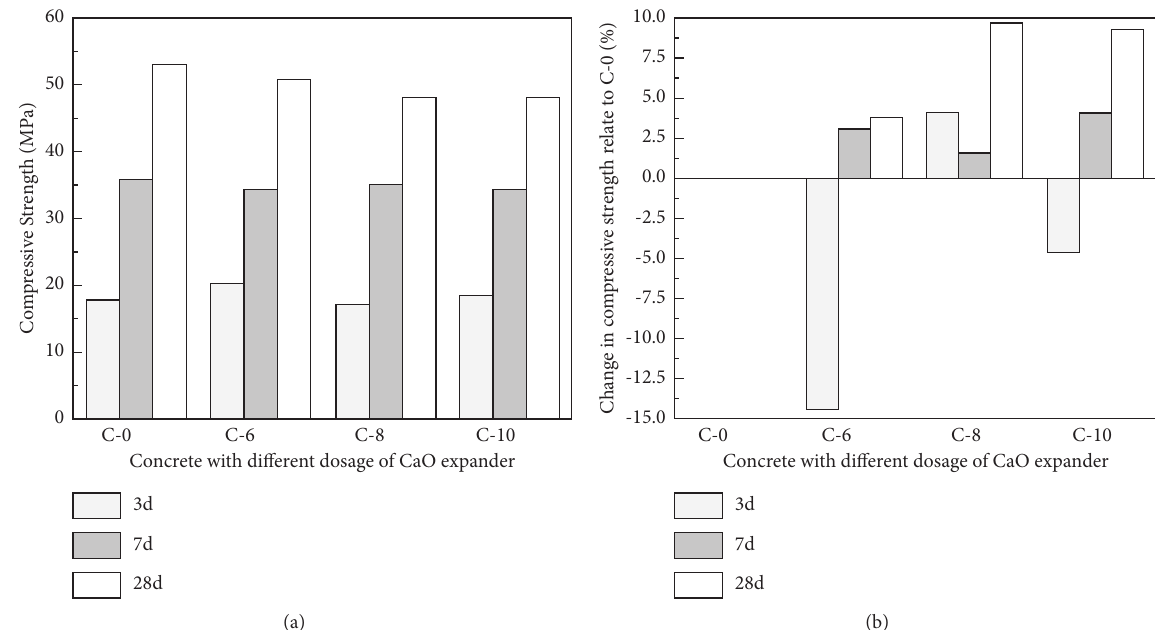
Figure 5: Compressive strength of early-age concrete with different contents of CaO expansion agent. (a) Early strength. (b) Early strength loss rate.